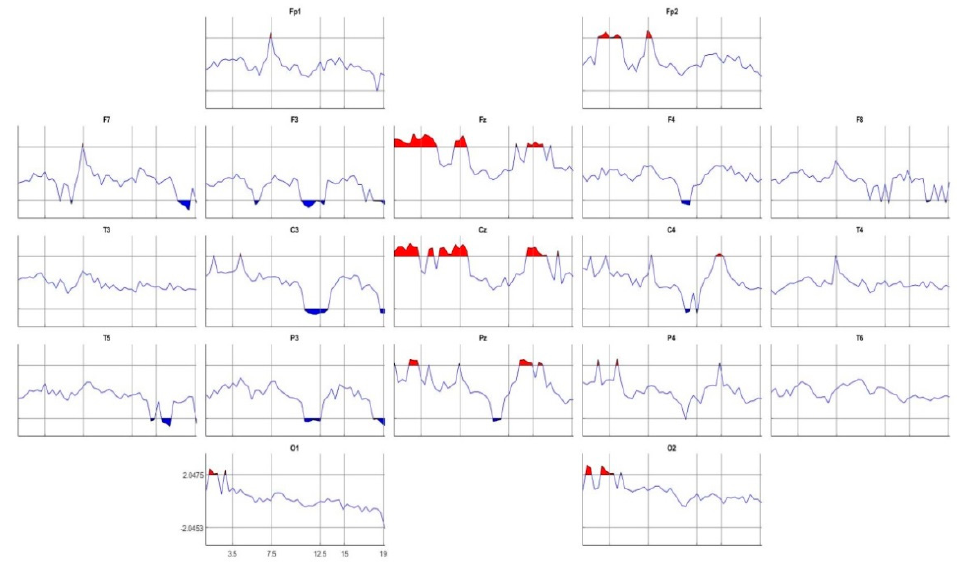
Figure 1. Results of the t -test between DD and NSRD groups for the Z-EEG spectra at all leads and frequencies. Main significant differences are an excess of activity of the DD group in the middle line in almost all frequency bands and a reduction of fast activity in the left fronto-parietal and temporal leads.